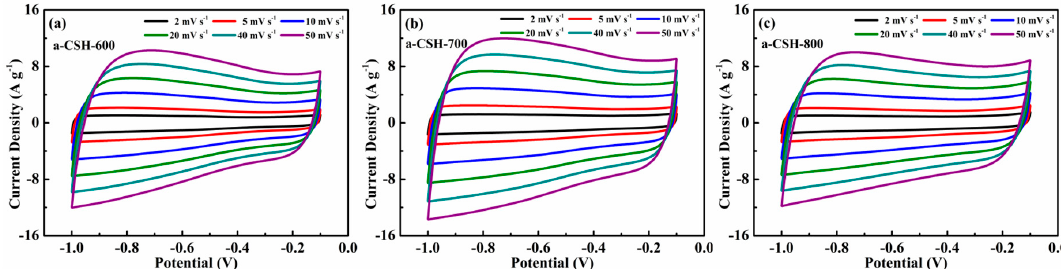
Figure 7. Electrochemical performance characteristics of a-CSHs measured in a three-electrode system in a 6 M KOH electrolyte: the cyclic voltammetry (CV) curves of ( a ) a-CSH-600, ( b ) a-CSH-700, and ( c ) a-CSH-800 at different scan rates.